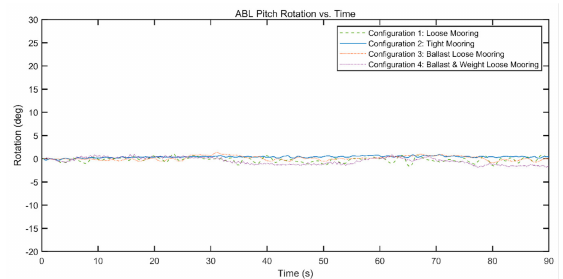
Figure A3. ABL wind pitch rotation for all configurations.